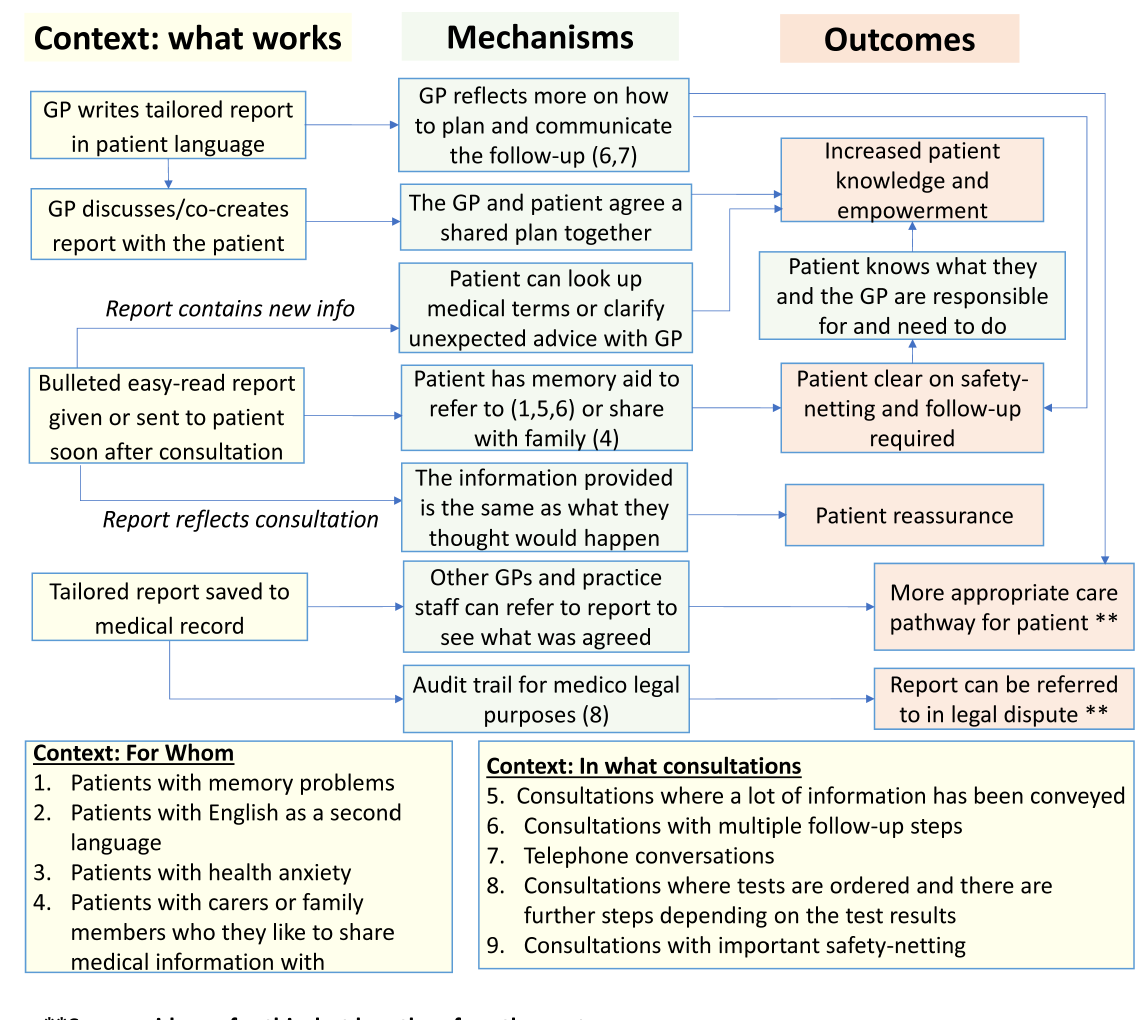
Figure 12. summary report, revised programme